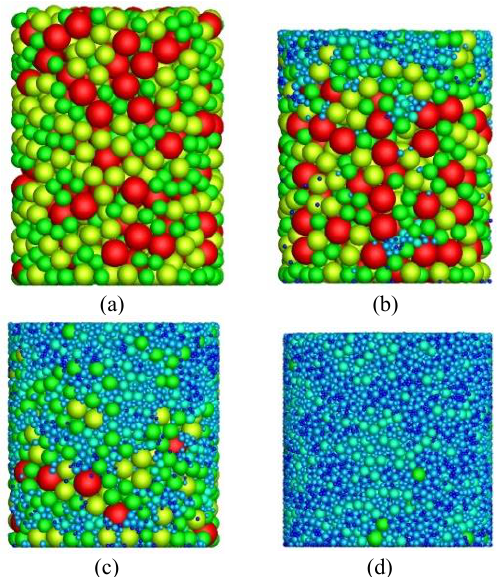
Fig. 3 Compacts with different compact stress. (a) initial compact (compact A), (b) 20 MPa (compact B), (c) 30MPa (compact C), (d) 70MPa (compact